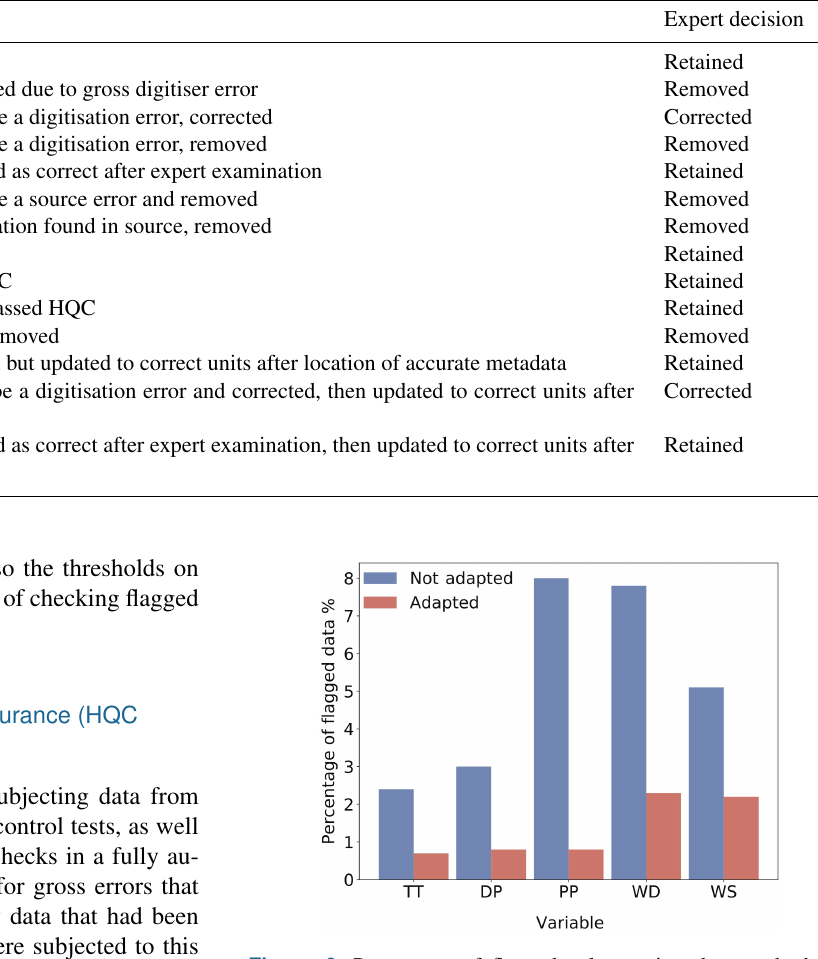
Figure 6. Percentage of flagged values using the standard QC tests developed for the UK Met Office Hadley Centre Global Sub- Daily Station Observations (HadISD), and the percentage of val- ues flagged using HadISD tests specifically adapted for this dataset (HQC). The variable acronyms are the same as those given in the text: temperature (TT), dew point temperature (DP), mean sea level pressure (PP), wind direction (WD), and wind speed